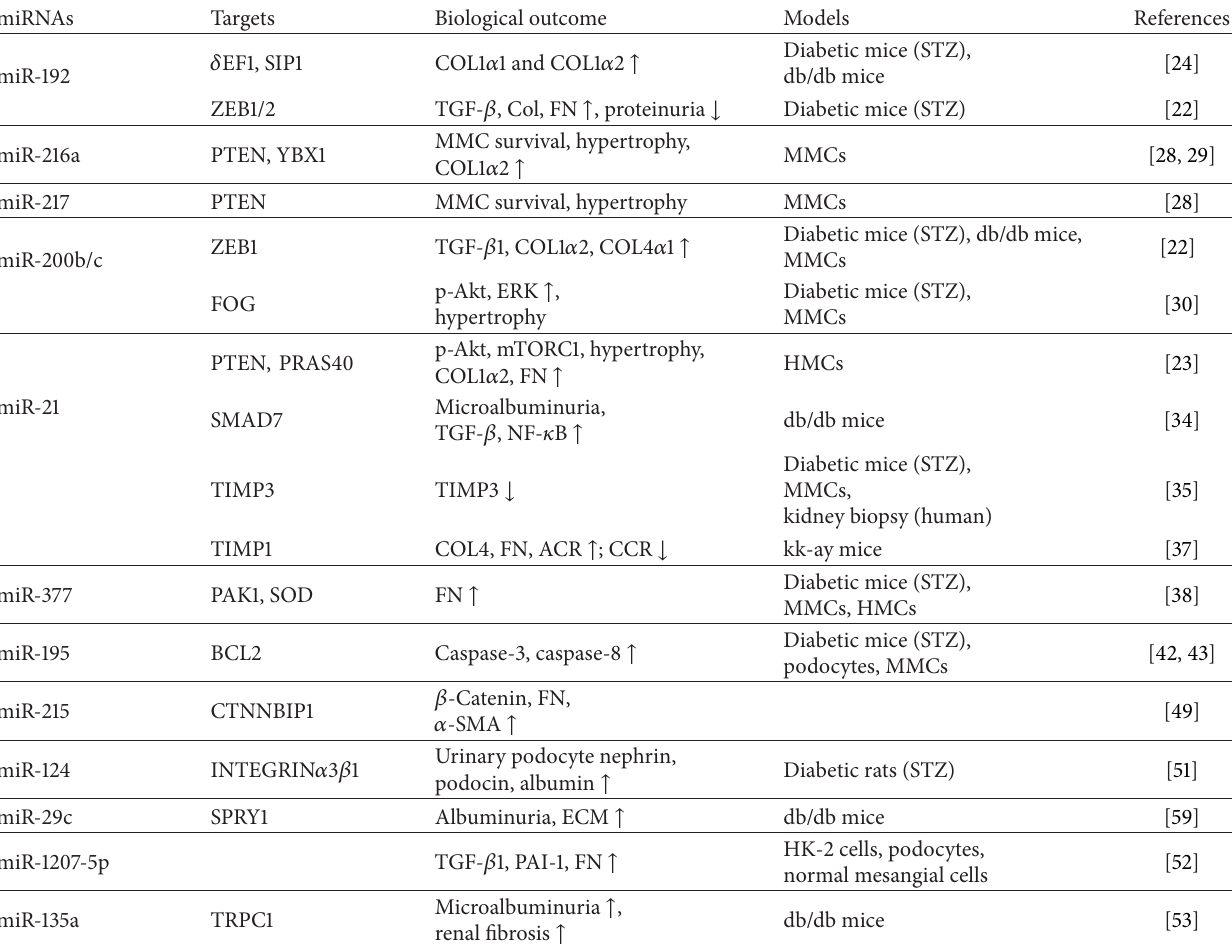
Table 1: Upregulated